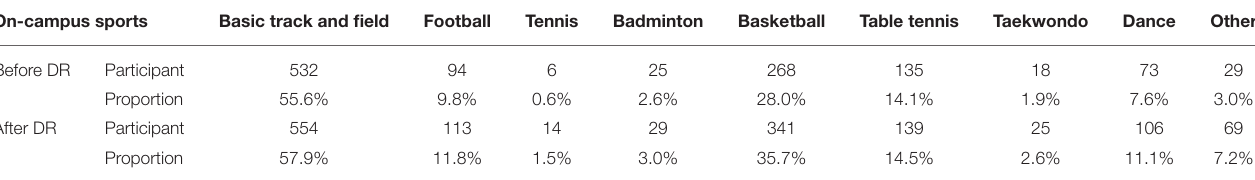
TABLE 6 | SPon-campus sports activities before and after